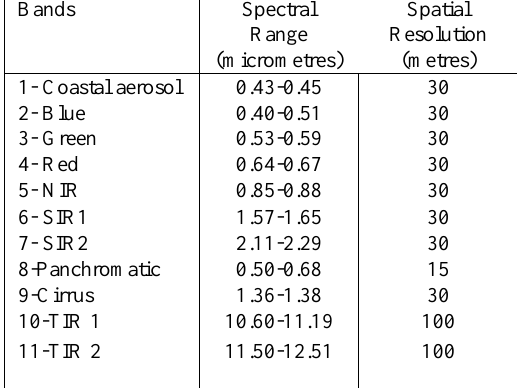
Table 1. Spectral and spatial resolution of Landsat